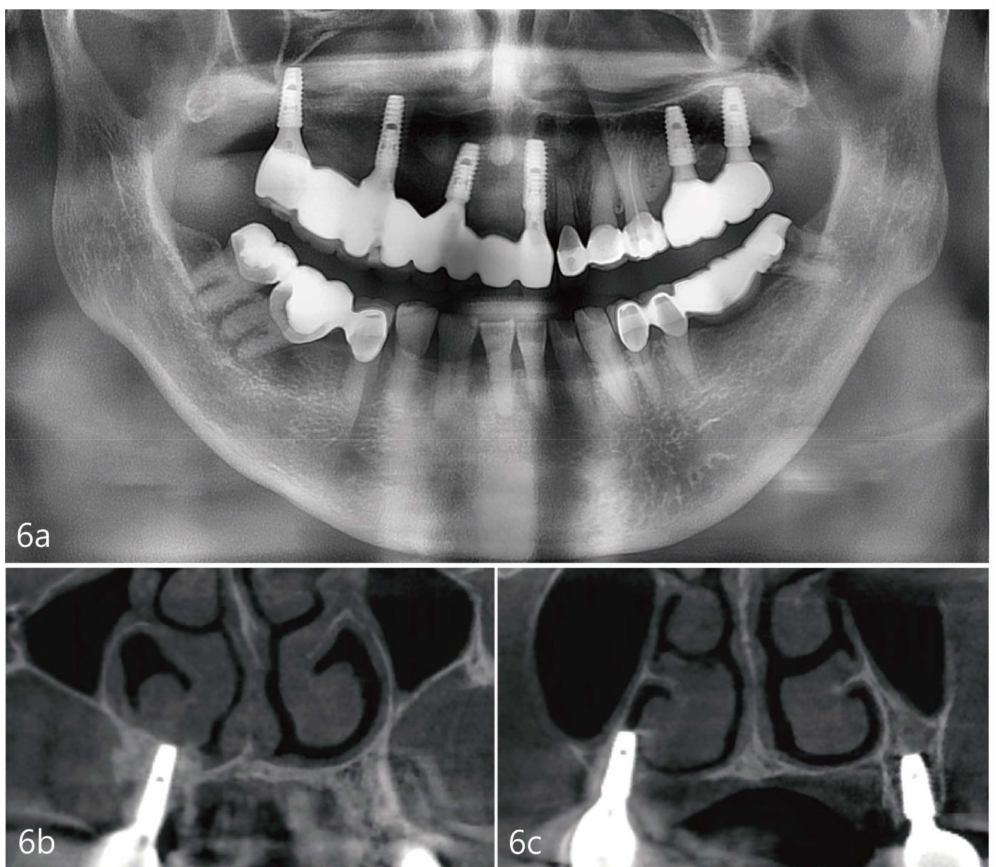
Figure 6. ( a ). Panoramic radiograph 2 years after prosthesis delivery. ( b ). Coronal view of the CBCT at the #4 site showing no marginal bone loss around the implant or other abnormal findings. ( c ). Coronal view of the CBCT at the #2 site showing no marginal bone loss around the implant or other abnormal